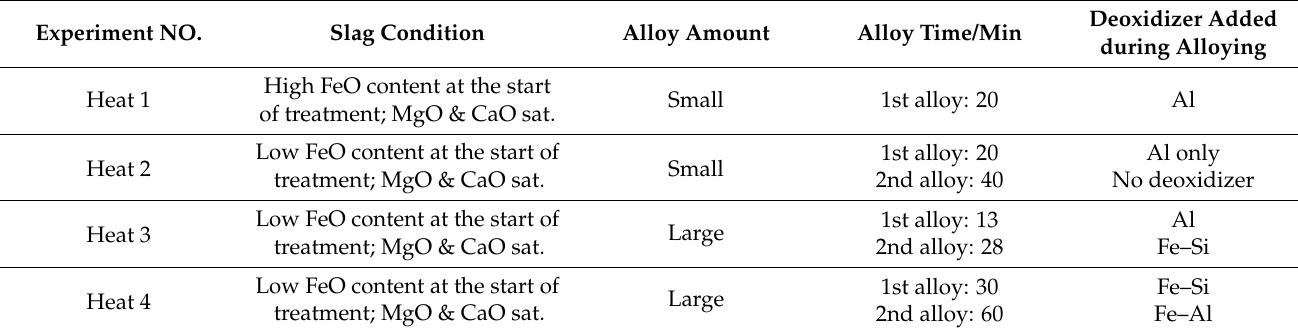
Figure 2. LF production practice and the sampling plan. Table 1. Experimental conditions.